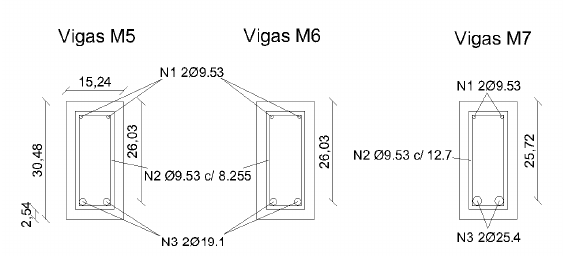
Figure 19: M5 to M7 beams cross section (dimensions in cm and bars diameter in mm).